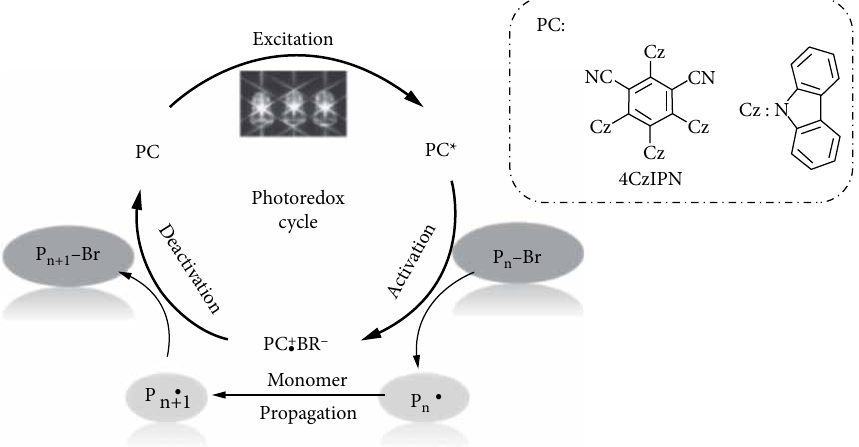
Figure 10: Proposed polymerization mechanism of photoinduced metal-free ATRP with ppm level of 4CzIPN as an organic photocatalyst. (Adapted with permission from Ref. [51]).